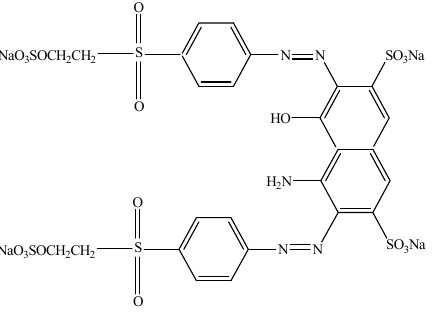
Figure 1. Molecular structure of Reactive Black 5 diazo compound with two N double bound N bounds.